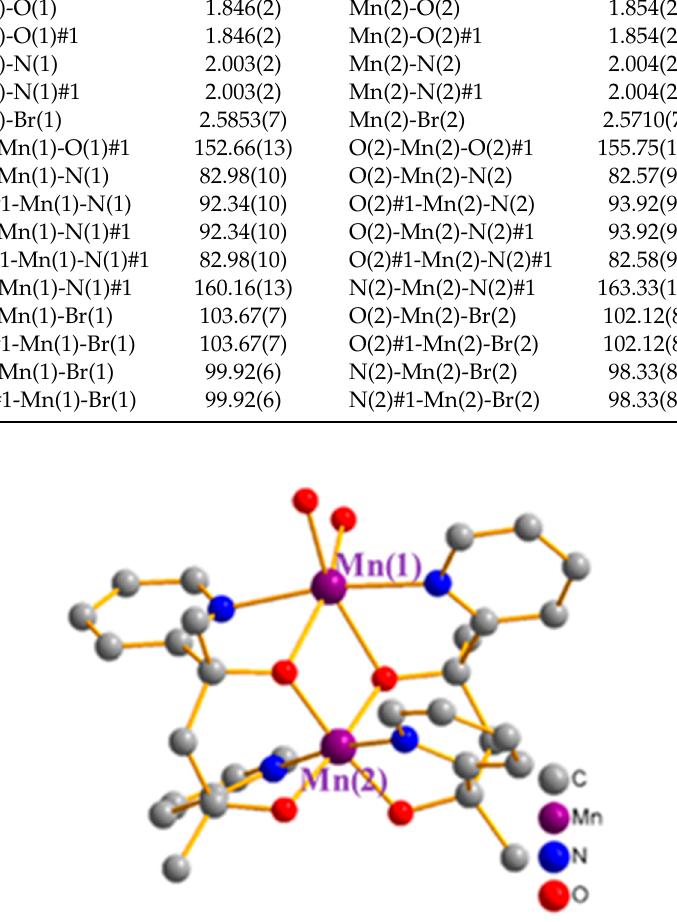
Figure 2. Structural plot of compound 2 . The Mn ion on the top represents Mn(II) and the one on the bottom is Mn(IV).